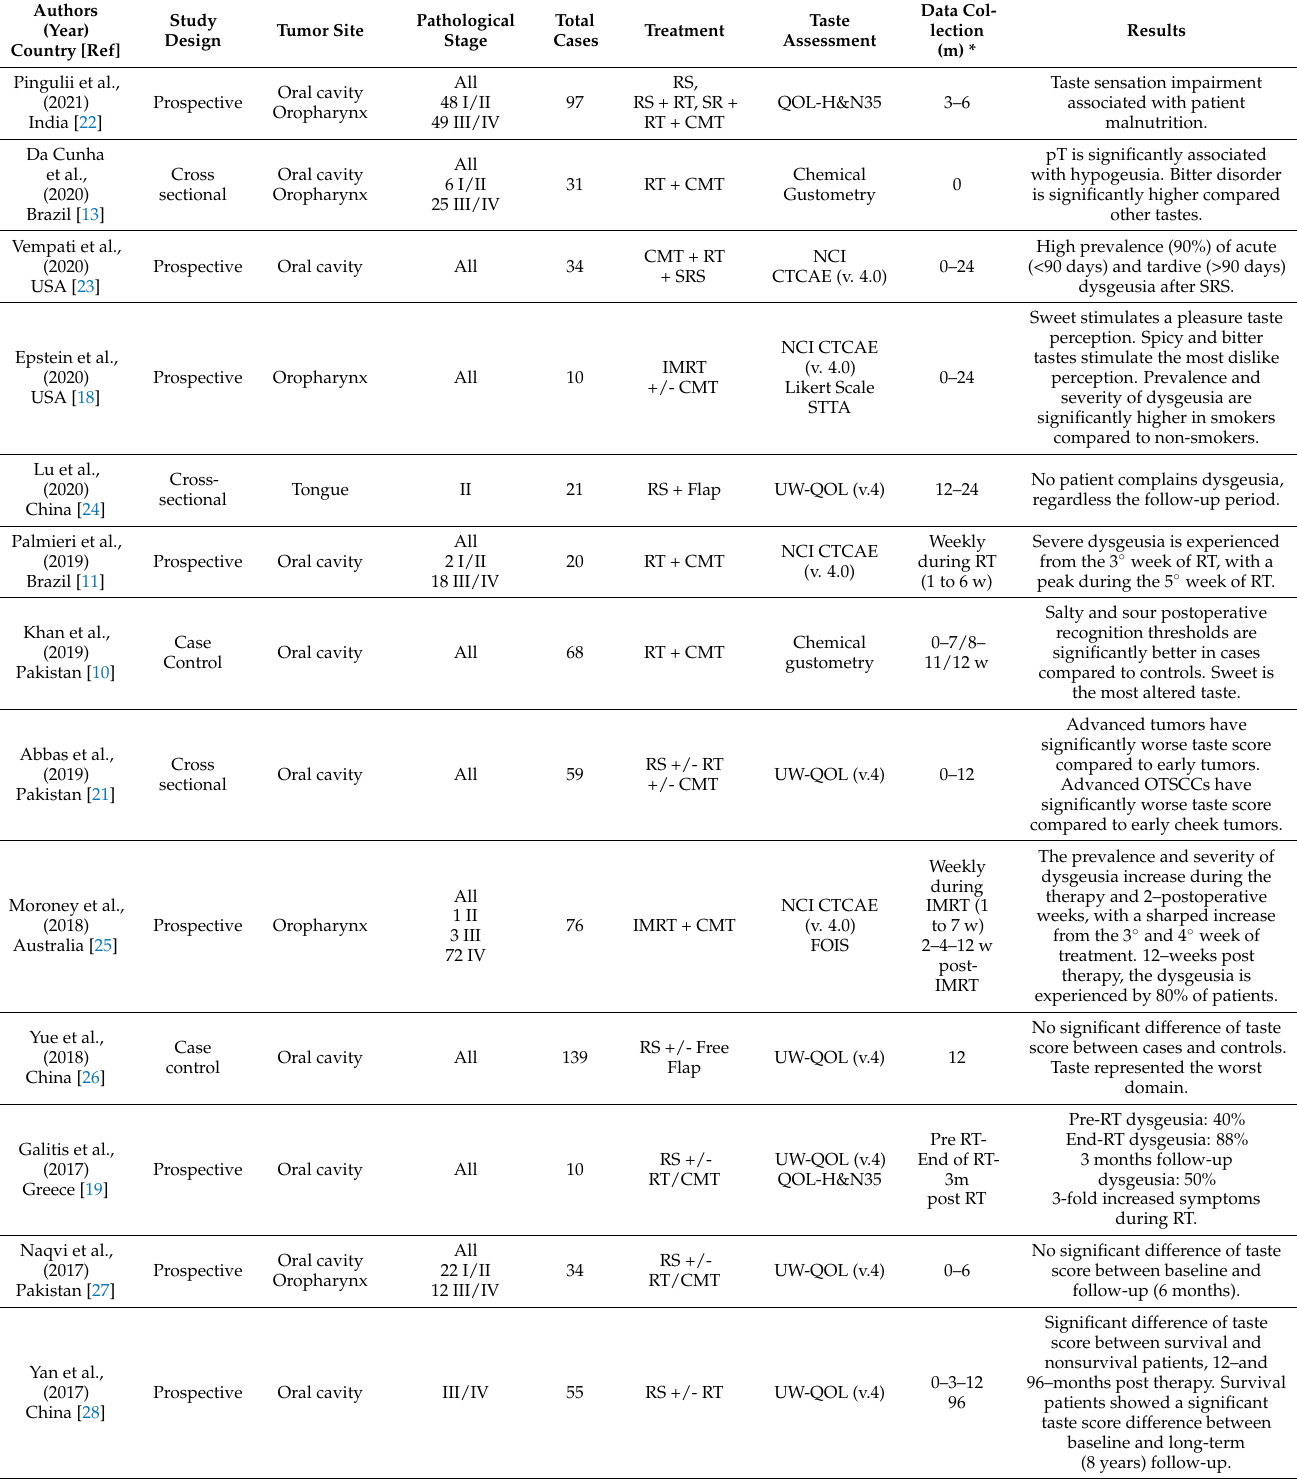
Table 1. Data collection of literature study, regarding therapy induced dysgeusia in OSCC and OPSCC included in the